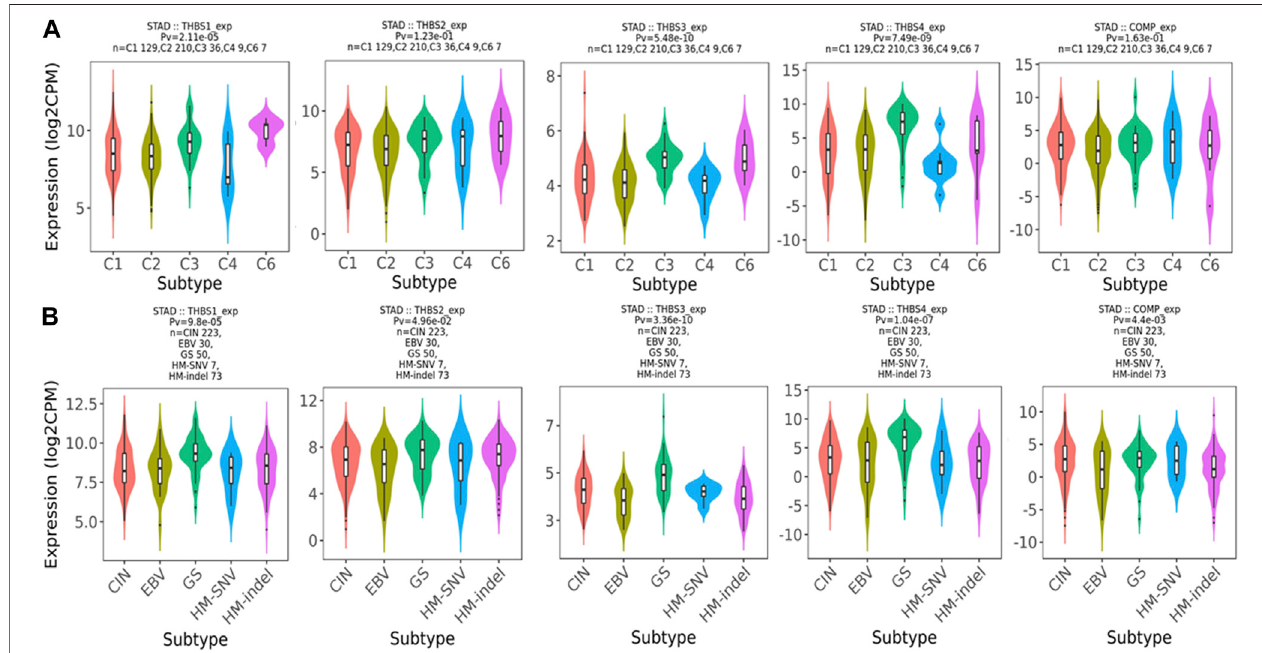
FIGURE10|(A) Associationsbetween THBSs expressionandimmunesubtypesingastriccancer(C1:woundhealing;C2:IFN- γ dominant;C3:in fl ammatory;C4: lymphocyte depleted; C5: immunologically quiet; C6: TGF- β dominant); (B) associations between THBSs expression and molecular subtypes in gastric cancer (CIN: chromosomal instable; EBV: Epstein – Barr virus – positive; GS: genomically stable; HM-SNV: hypermutated with elevated single nucleotide variation; HM-indel: hypermutated enriched for insertion/deletion)